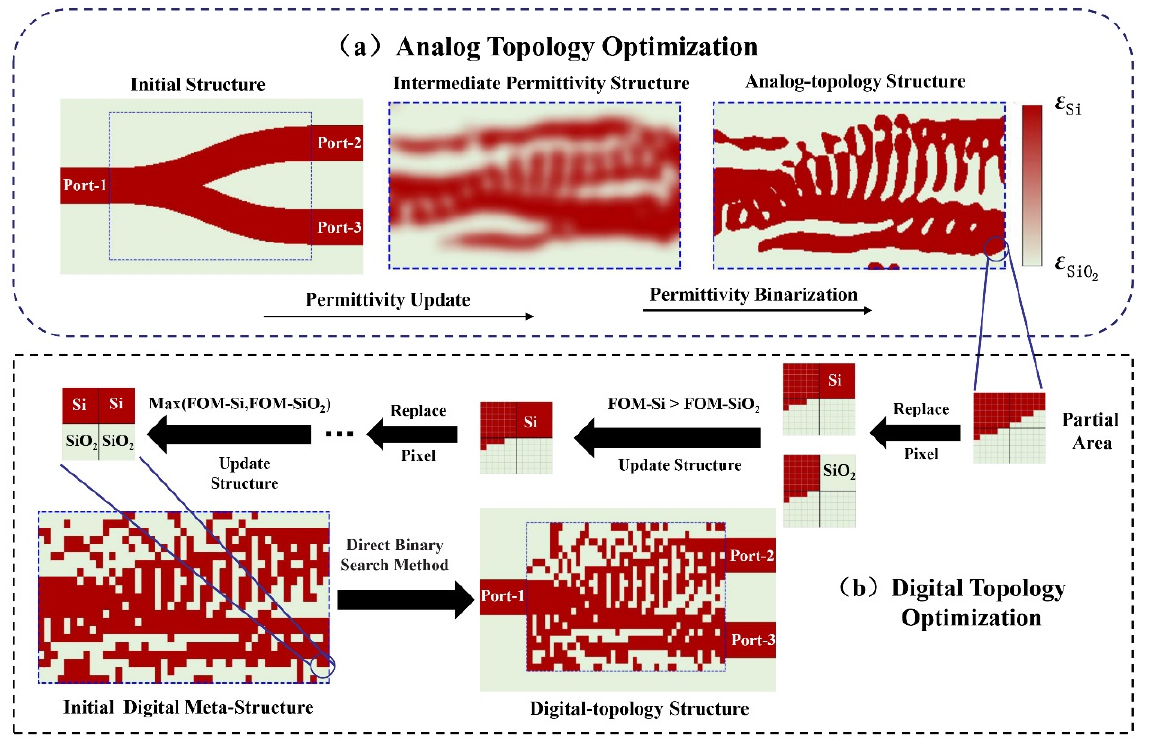
Figure 1. ( a ) and ( b ) are the processes of the ATO and DTO, respectively.